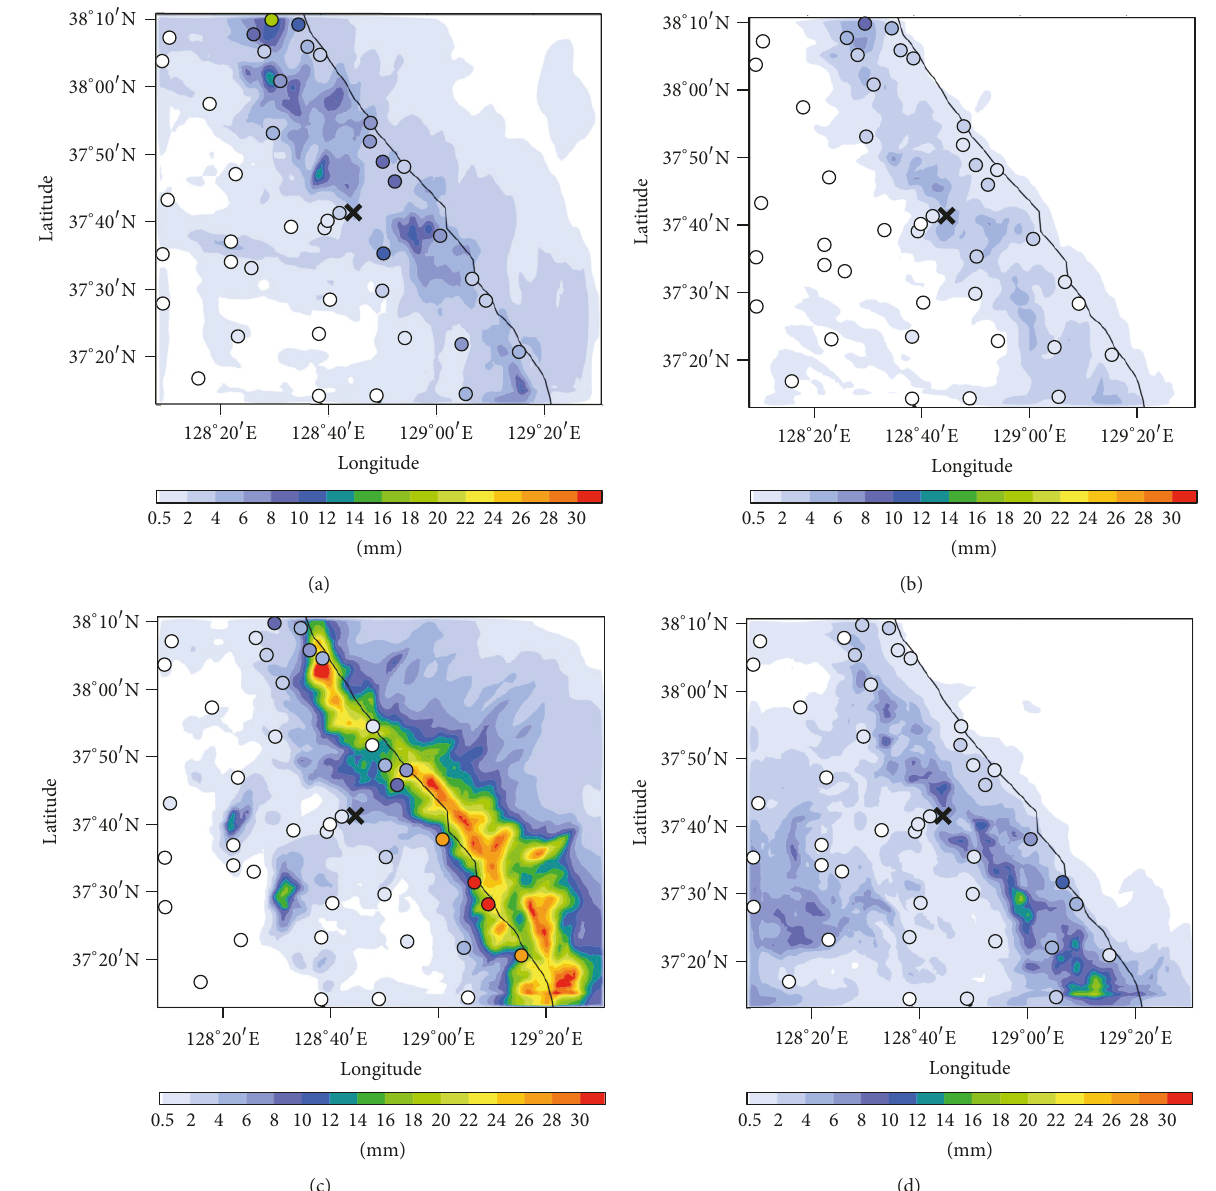
Figure 3: The 12h accumulated precipitation (mm) of nonseeded simulation and rain gauges for (a) EXP1, (b) EXP2, (c) EXP3, and (d) EXP4. The simulated precipitation is color shaded, overlaid by the rain gauge precipitation in color-filled circles. The cross indicates the location of